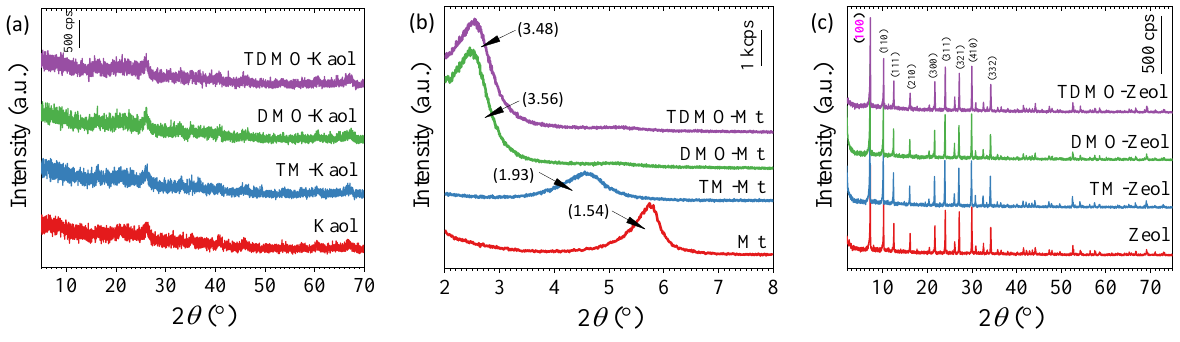
Figure 2. XRD patterns of the original and grafted ( a ) Kaol, ( b ) Mt, and ( c )